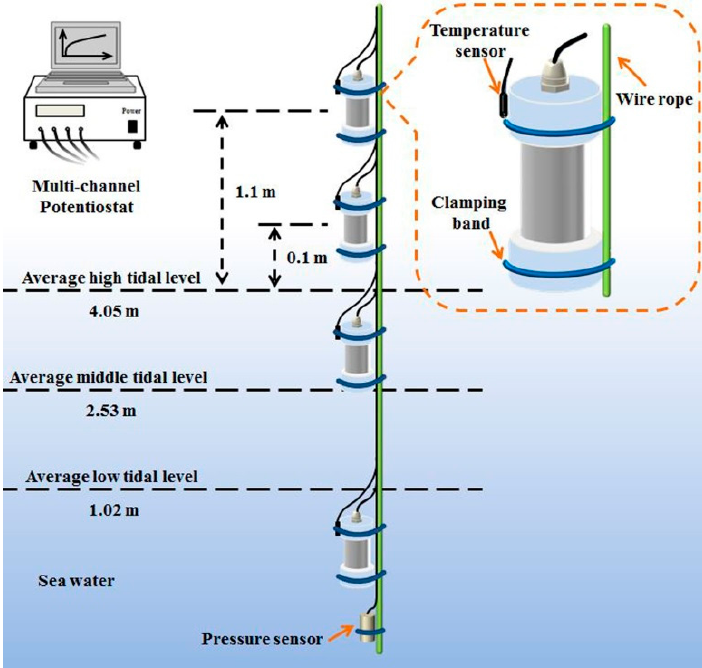
Figure 3. Schematic diagram of the outdoor hydrogen permeation test.